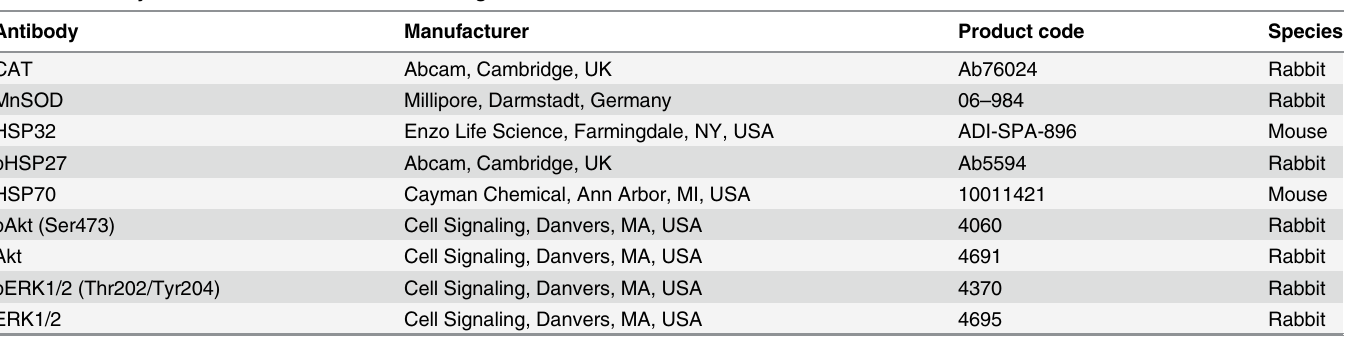
Table 2. Primary antibodies used for western